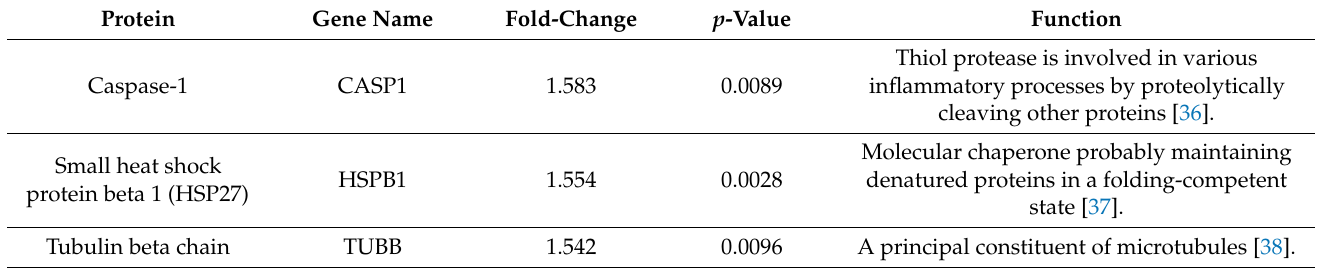
Table 1. Differentially expressed proteins from ZIKV-positive and negative placenta were selected for validation. Proteins selected for validation of quantitative proteomics. Quantitative proteomics results are included for the selected proteins and brief descriptions.